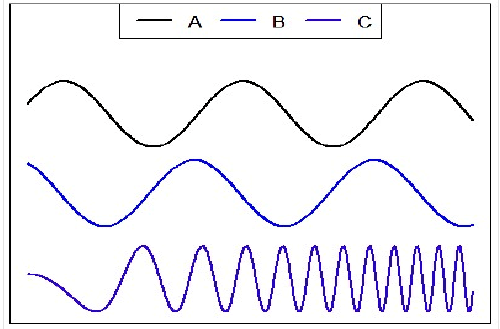
Figure 1. Coherent and incoherent